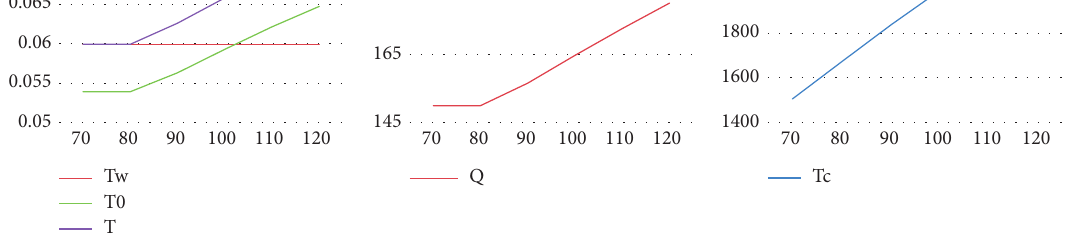
Figure 9: The effect of parameter A on decision